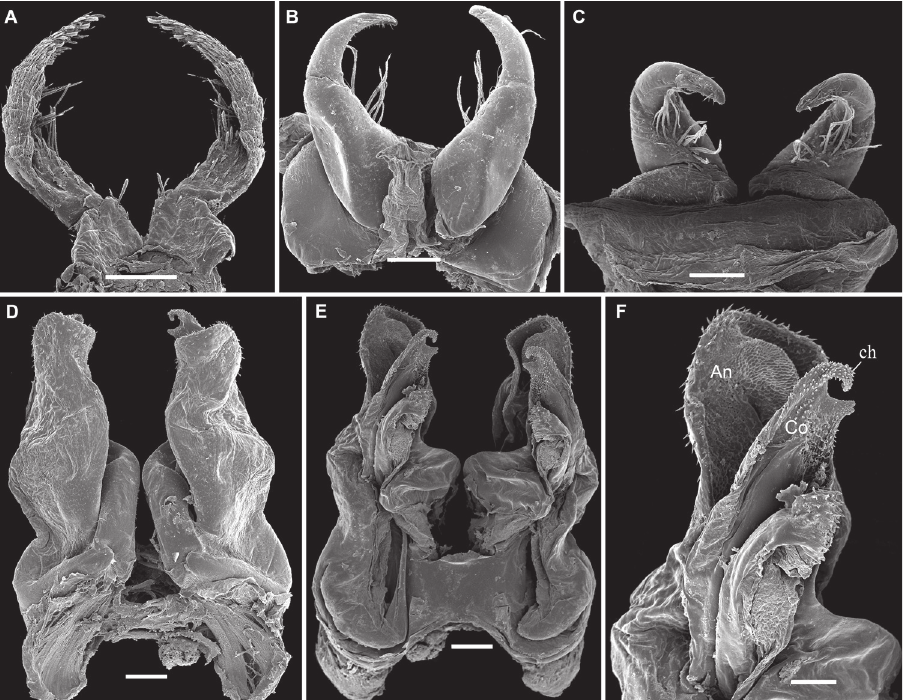
Figure 3. Stemmiulus mbalmayoensis Nzoko Fiemapong & VandenSpiegel, sp. n. ♂ paratype (SEM). A first leg-pair oral view B, C leg-pair two, oral and caudal views, respectively D, E leg-pair 8 (gonopods) oral and caudal views, respectively F apical part of right gonopod showing angiocoxite ( An ) partly sur- rounding colpocoxite ( Co ). Scale bars 200 µm ( A ), 100 µm ( B–E ), 50 µm ( F